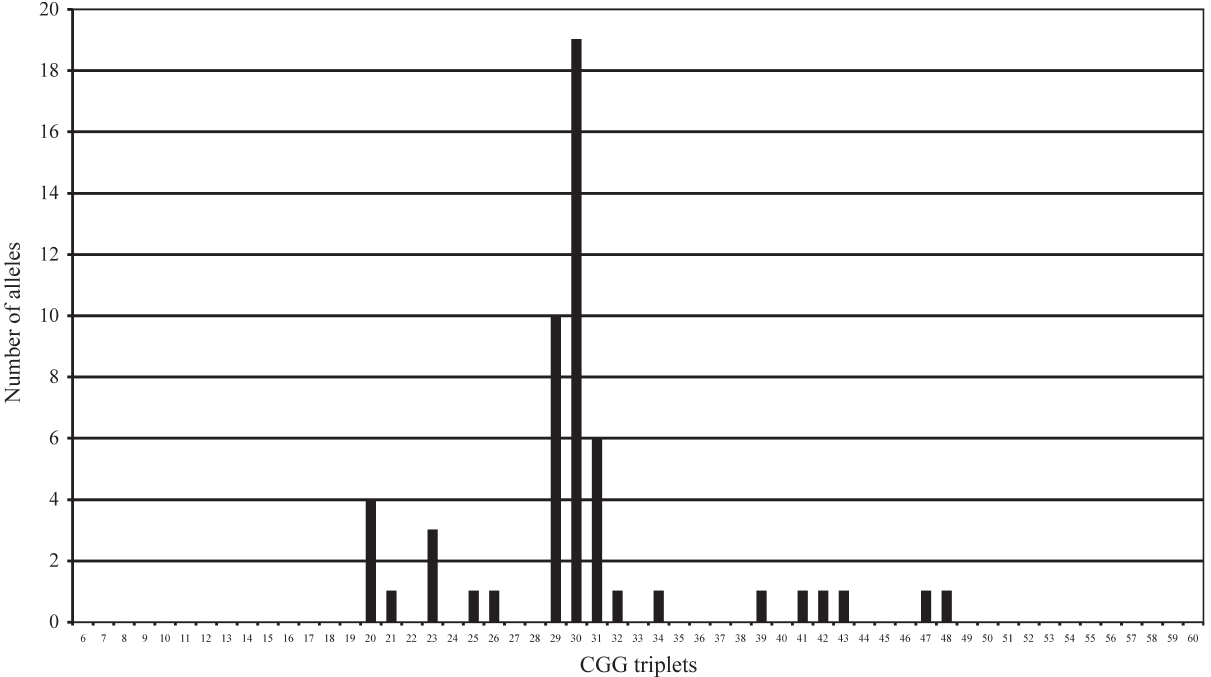
Figure 1 - FMR1 alleles according to the length of the CGG repeat in 53 unrelated males from the population of São